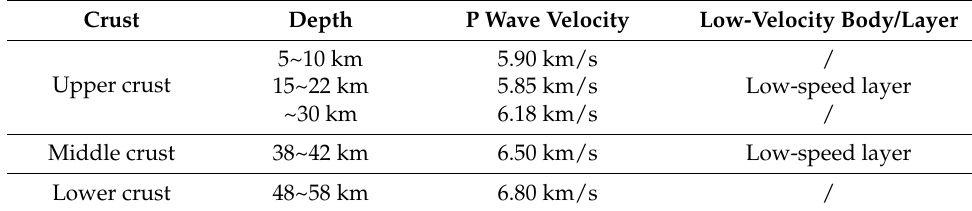
Table 2. Initial model of crustal